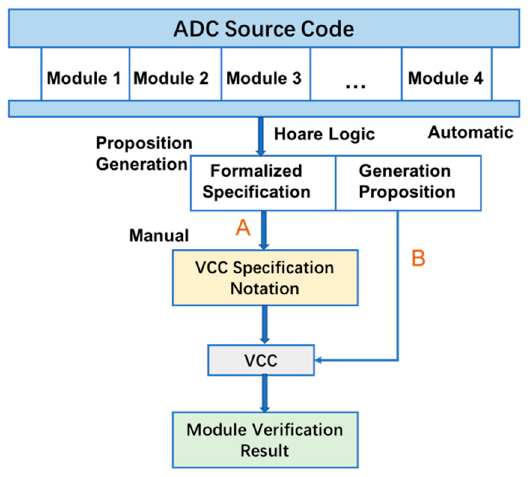
Figure 6. Verification process of compliance from source code to requirements.